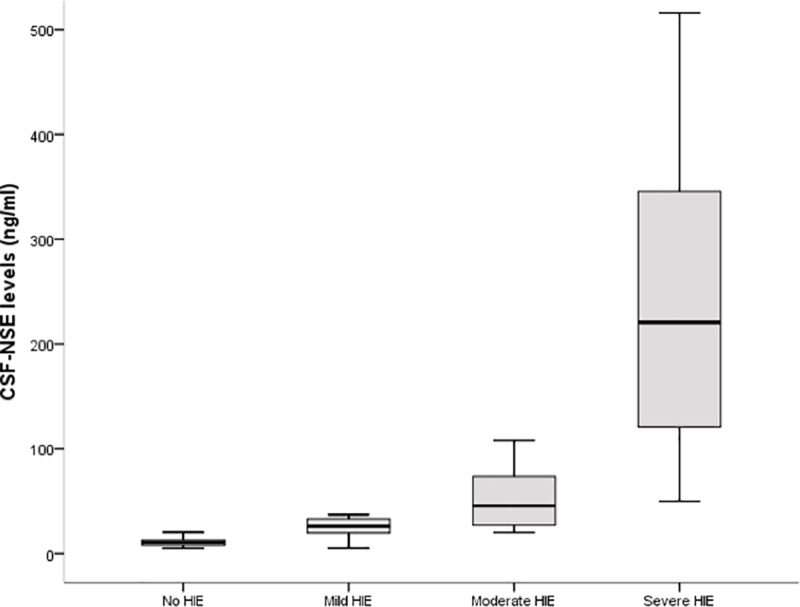
Cerebrospinal fluid levels of neuron-specific enolase in 59 controls and 43 infants with HIE, according to the severity of the encephalopathy.CSF-NSE levels in the control group were 10.6 (7.7; 12.9). CSF-NSE levels in 20, 12, and 11 infants with severe, moderate, and mild HIE, respectively, were 220.5 ng/ml (120.5; 368.8), 45.5 ng/ml (26, 75.3), and 26 ng/ml (18, 33). No statistically significant differences were found between any of the grades of HIE compared to controls or between any of the grades of HIE (analysis of variance after log-transformation of CSF-NSE values, with Tukey post hoc pairwise analysis); p<0.05. HIE: hypoxic-ischaemic encephalopathy; CSF-NSE: cerebrospinal fluid–neuron specific enolase.